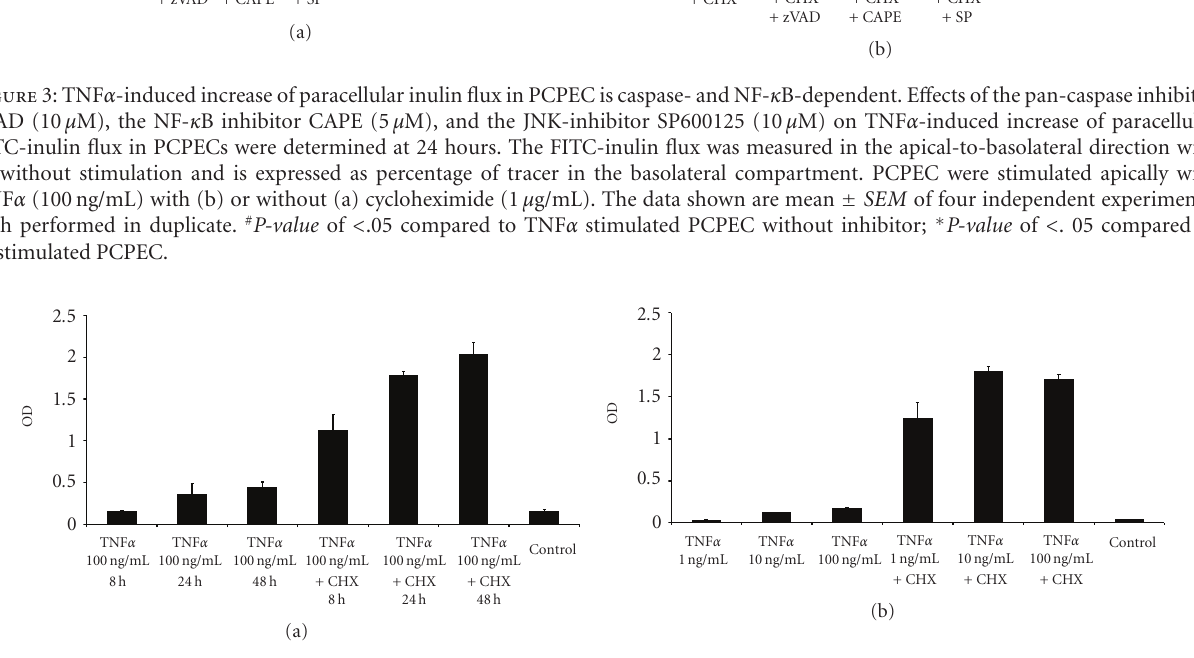
Figure 4: TNF α induces DNA-fragmentation in PCPEC. TNF α -induced apoptosis was determined by ELISA measuring the number of cellular histone-associated DNA fragments. (a) The concentration of histone-associated DNA-fragments was determined 8 hours, 24 hours, and 48 hours following apical stimulation with TNF α . PCPEC were stimulated apically with TNF α (100ng/mL) alone or costimulated with cycloheximide (1 μ g/mL). The data shown are mean ± SEM of three independent experiments, each performed in duplicate. (b) Appearance of histone-associated DNA fragments after 24 hours treatment with di ff erent doses of TNF α (1, 10, 100ng/mL) in presence or absence of cycloheximide (1 μ g/mL). A representative experiment out of three performed in duplicates is shown. OD, optical